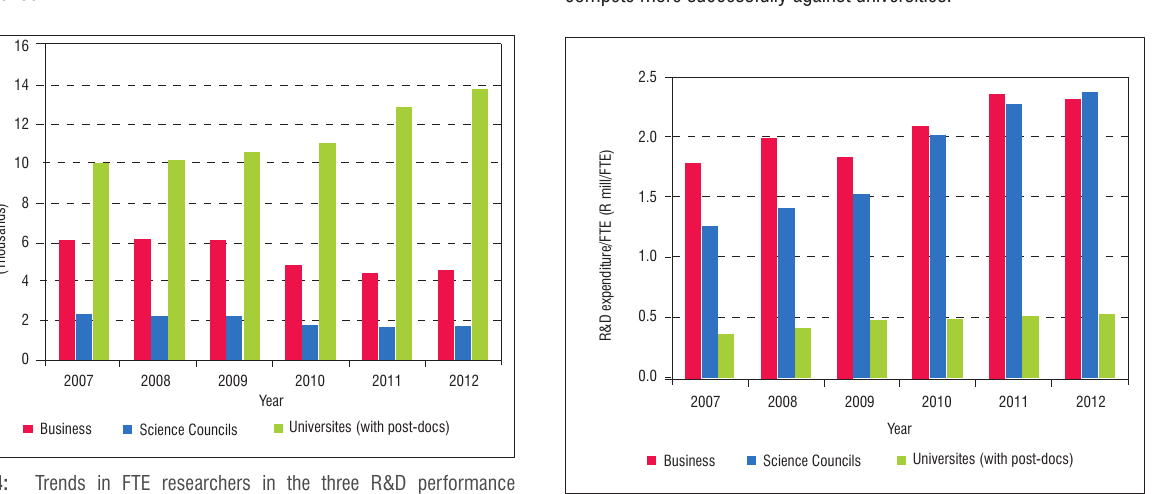
Figure 6: Trends in South Africa’s R&D expenditure per FTE. Business